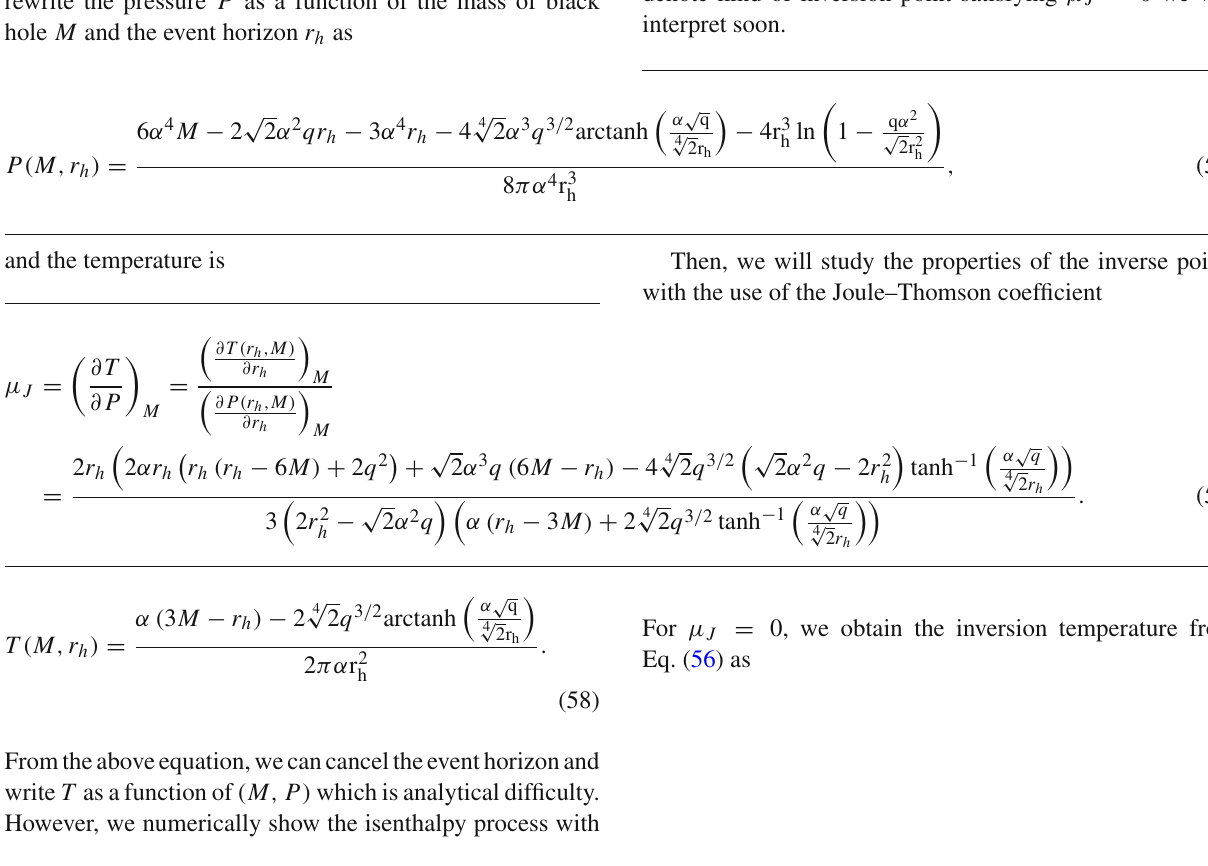
fixed M = 15 , 18 , 20 , 22 from bottom to top in Fig. 5 where we set q = 10 and α = 1. The red points in each process denote kind of inversion point satisfying μ J = 0 we